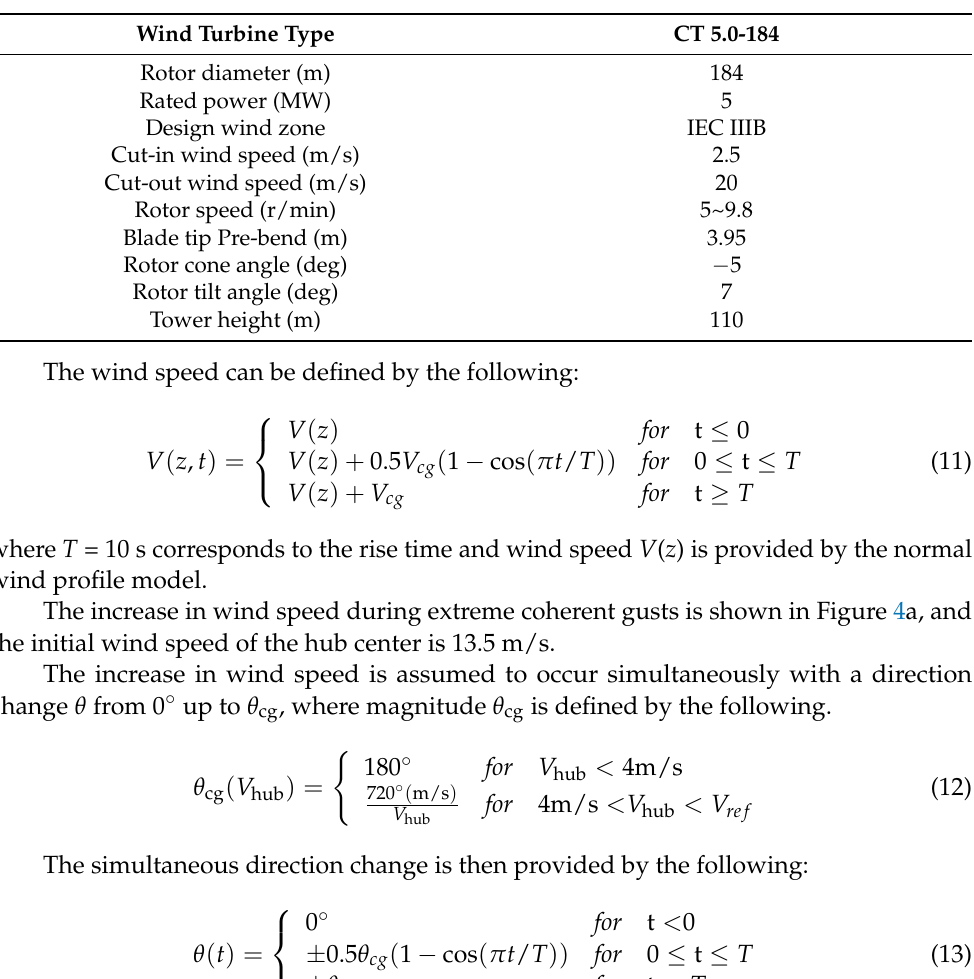
Table 1. Wind turbine information and simulation parameters.